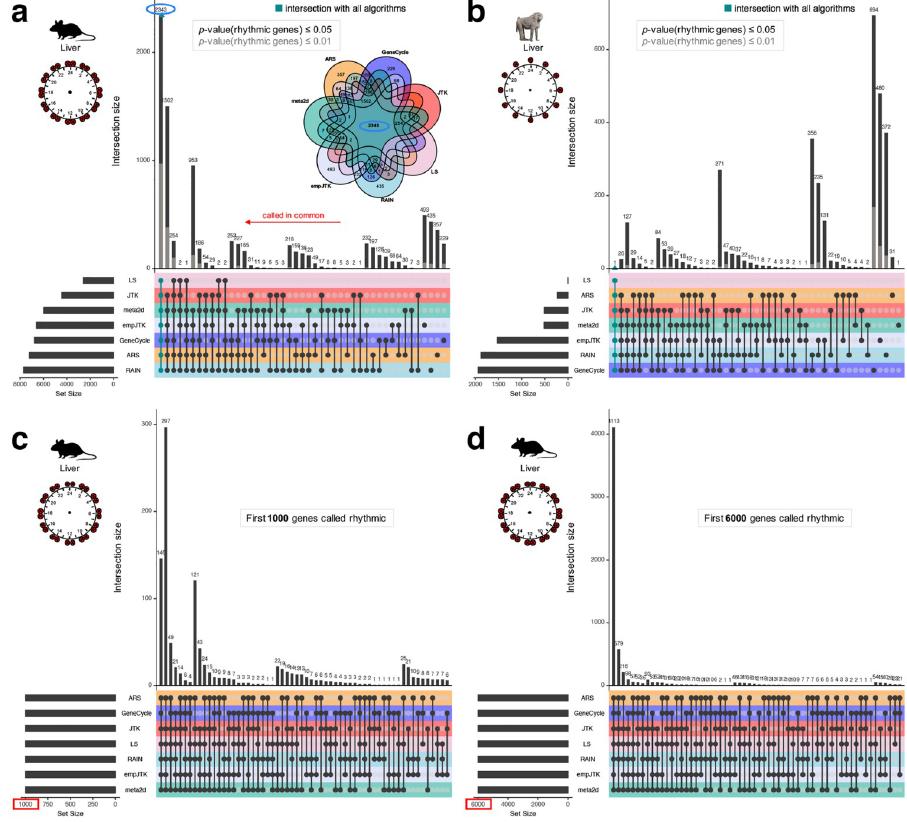
Fig 4. Methods detect the same first top rhythmic genes, but with inconsistencies in the meaning of their p -values. Upset diagrams show the number of rhythmic genes called in common by the methods. Each intersection is exclusive, i.e. one gene can appear in only one intersection. (a,b) Upset diagram for mouse liver dataset (microarray) ( a ) and baboon liver dataset ( b ) for the p -value thresholds of 0.05 (black) or 0.01 (grey) for calling genes rhythmic. The Venn diagram ( a ) illustrates the upset diagram with, for instance, 2343 genes called rhythmic by all methods. (c,d) Upset diagram for mouse liver dataset (microarray) for the first 1000 ( c ) or 6000 ( d ) genes detected rhythmic for each method. With a smaller number of top rhythmic genes, the overlap between methods is weaker. Images credit: Anthony Caravaggi (mouse) and wikipedia GNU GPL Muhammad Mahdi Karim (baboon).